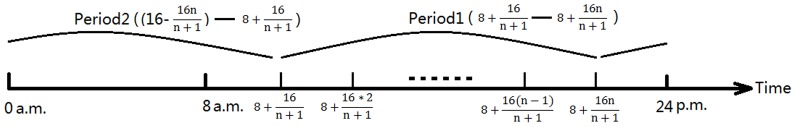
Microblog delay time calculation.